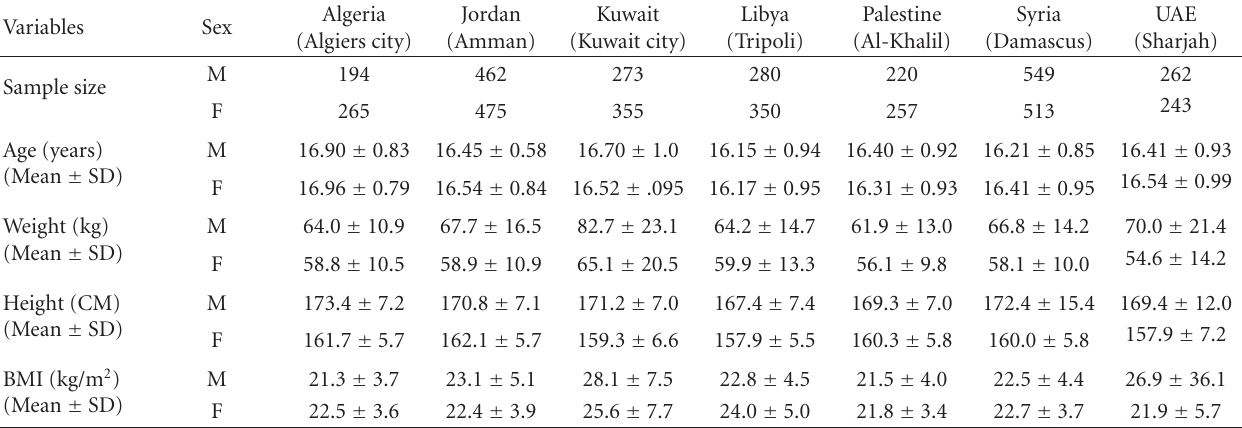
Table 1: Sample size, means, and standard deviations (SD) for age, weight, height, and BMI of adolescents (15–18 years) in seven Arab countries a .